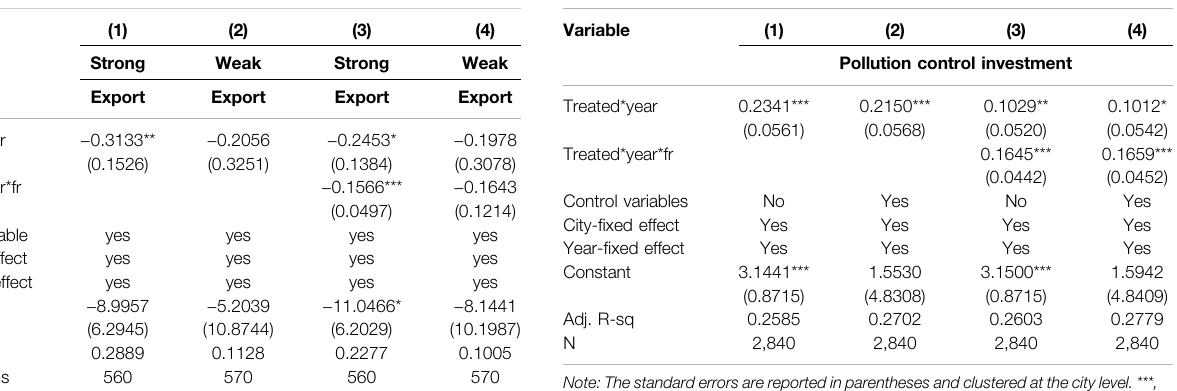
TABLE 9 | Stringency heterogeneity test. TABLE 10 | Test for the mechanism: cost